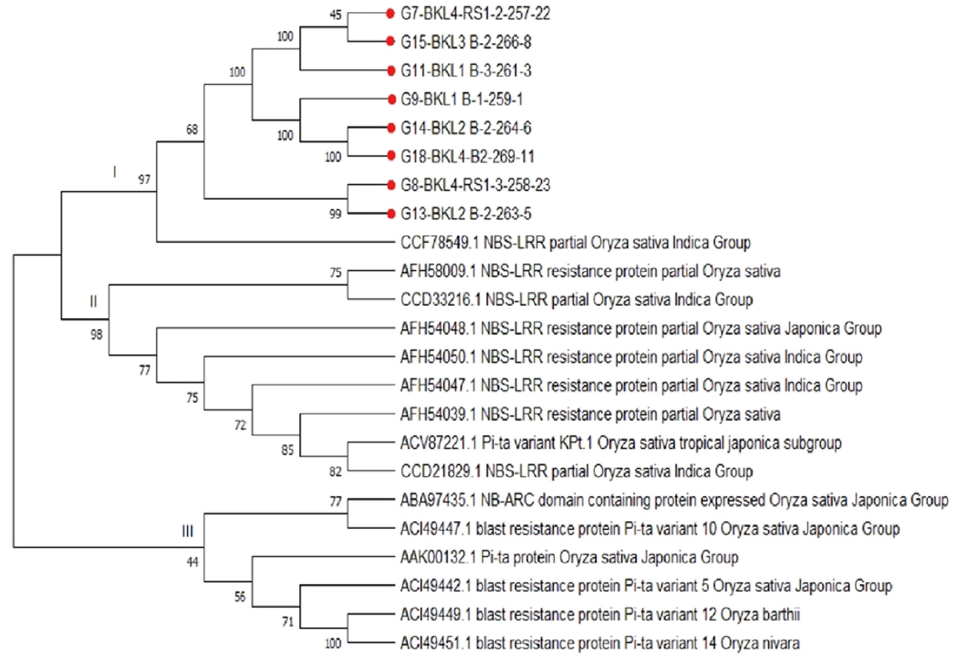
Figure 7. Phylogenetic tree constructed using neighbor-joining approaches and 1000 bootstrap replications to compare amino acid sequences from eight rice lines identified by the Pita2 gene.